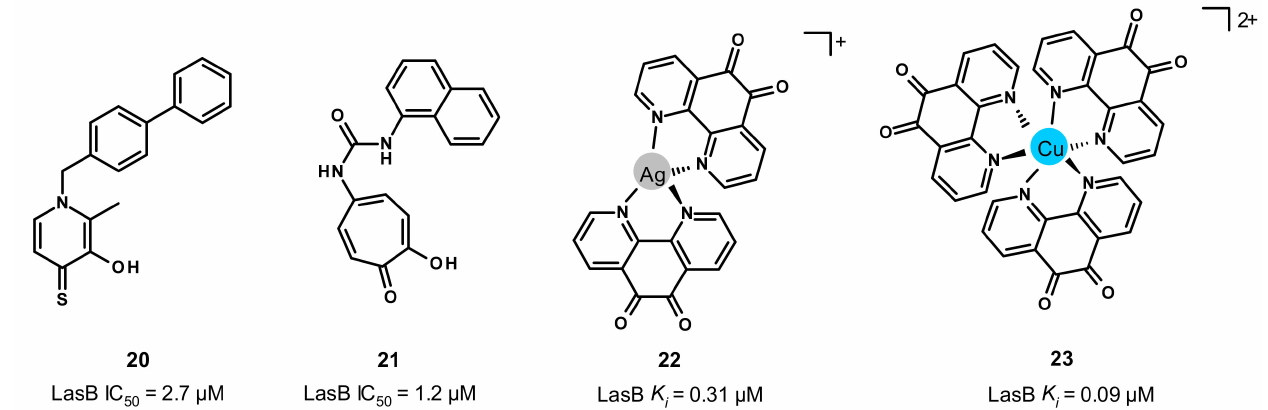
Figure 13. Chemical structures and biochemical activities of compounds 20 – 23 . IC 50 and K i values were extracted from the original publications